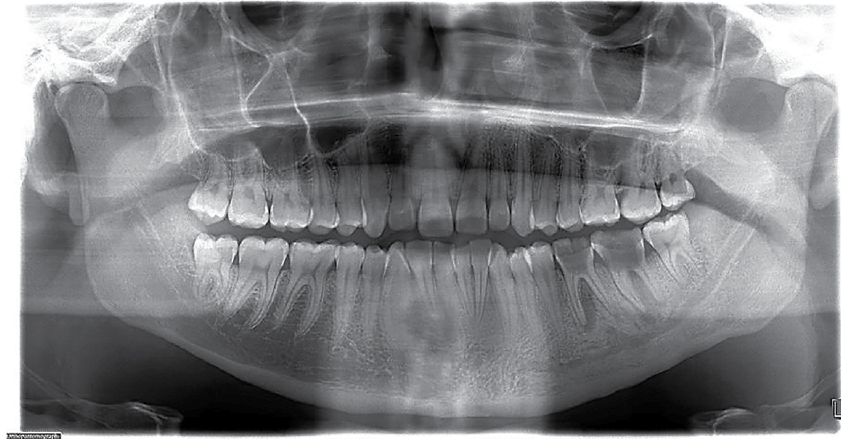
Figure 5- Case 11. The giant osteosclerotic lesion is located around the root of the maxillary right central incisor. Additionally, right lateral incisor and mandibular left canine are hypodontic. Note an enamel pearl in the neck of the mandibular right first molar